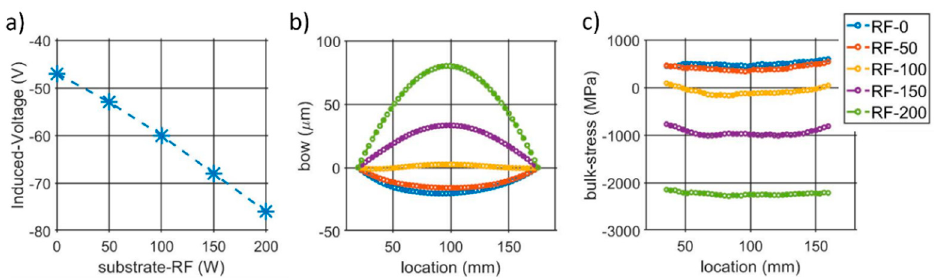
Figure 1. ( a ) Induced substrate DC biases per different RFs. ( b ) Wafers’ curvatures measured with a Flexus Tencor after AlScN depositions and ( c ) corresponding bulk stresses extracted though Stoney equations.